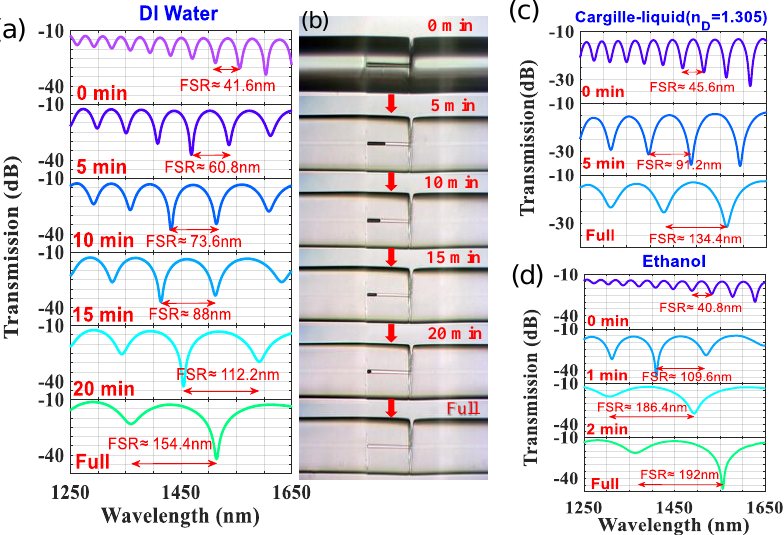
Figure 3. Evolutions of ( a ) duration corresponding spectra and ( b ) microphotographs of the DI-water-filled into the proposed LLCFMZI. Optical spectra evolution for filling ( c ) Cargille-liquid (n D = 1.305) and ( d ) ethanol, respectively.